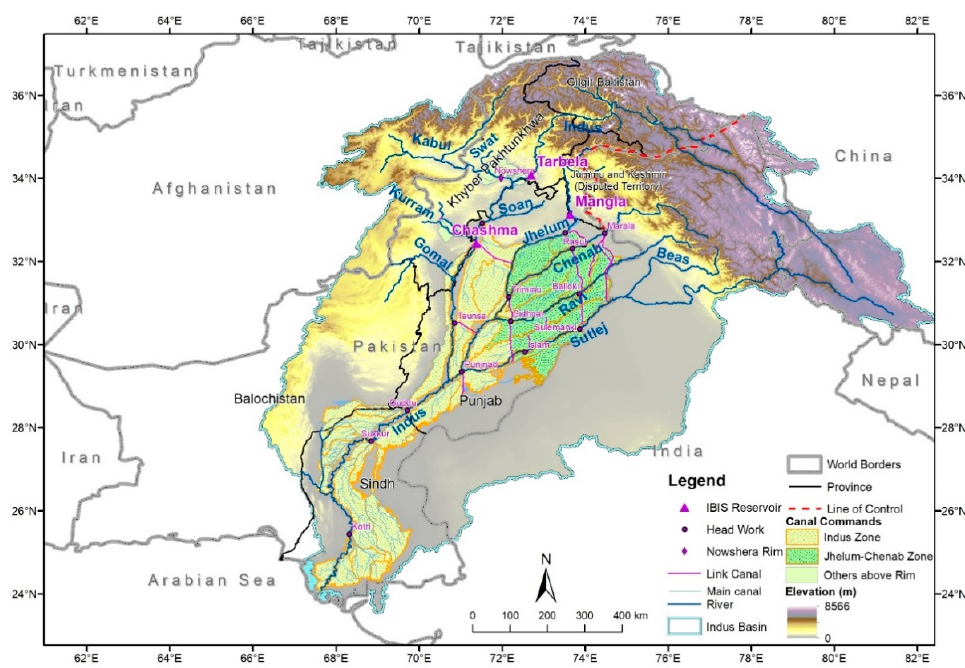
Figure 1. The Indus River system, showing major reservoirs, headworks, provincial boundaries, the Indus Basin Irrigation System (IBIS) and the Indus and Jhelum-Chenab (J-C) management zones (systems) in Pakistan. Tarbela, Mangla, Marala, Nowshera, Balloki and Sulemanki are considered remote inflow measurement (rim) stations for IBIS. For a detailed schematic diagram of the IBIS (depicting the current storage and canal system as of 2020), refer to Figure A1 in Ahmad et al. [12].